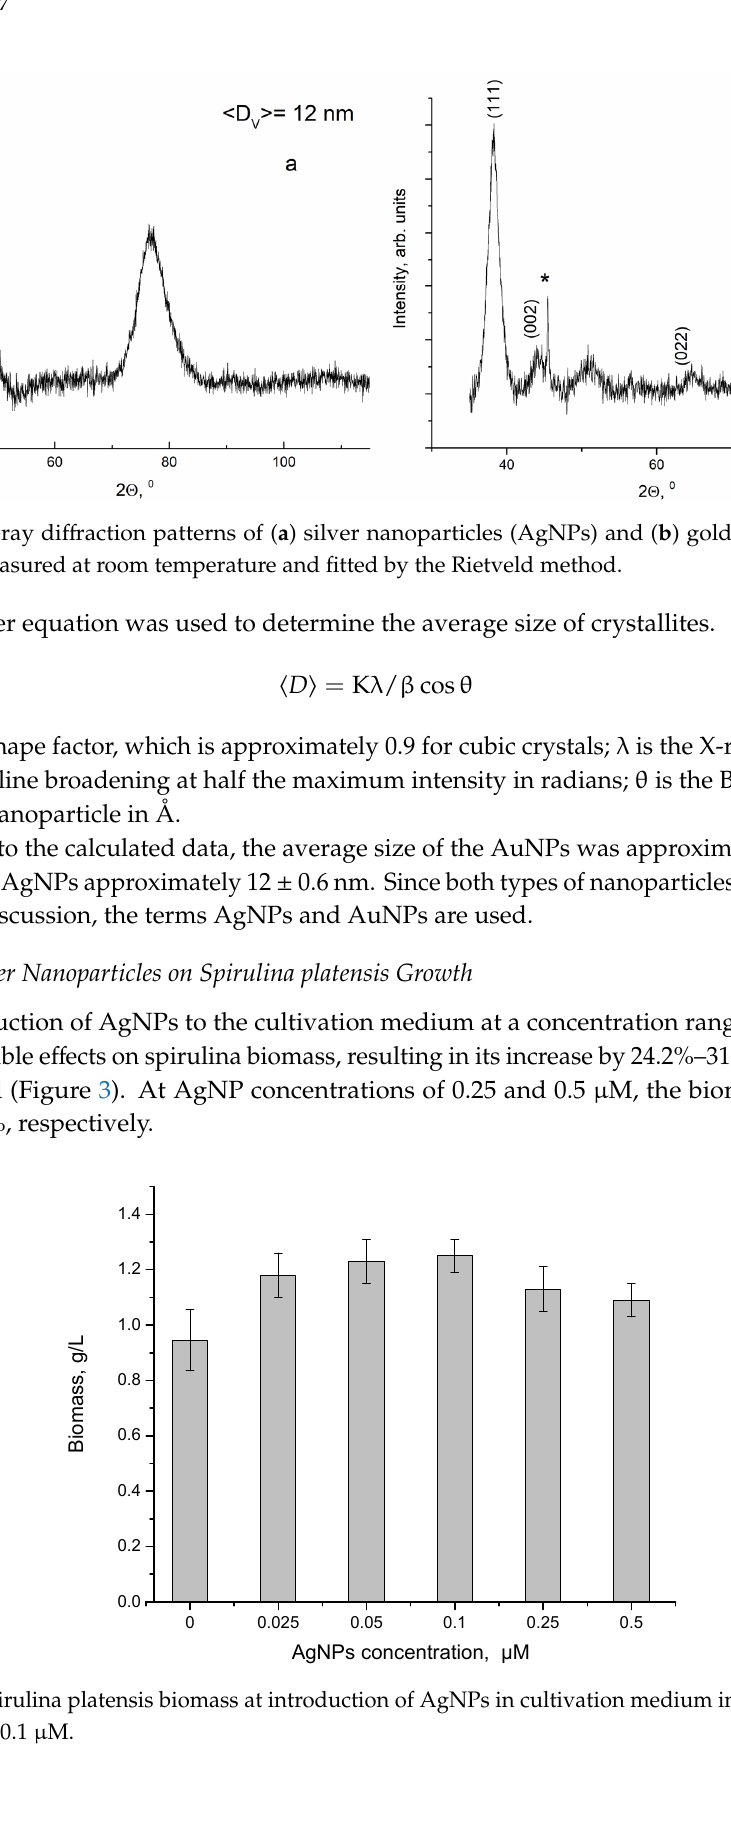
Figure 3. Spirulina platensis biomass at introduction of AgNPs in cultivation medium in concentration range 0.025–0.1 µM .